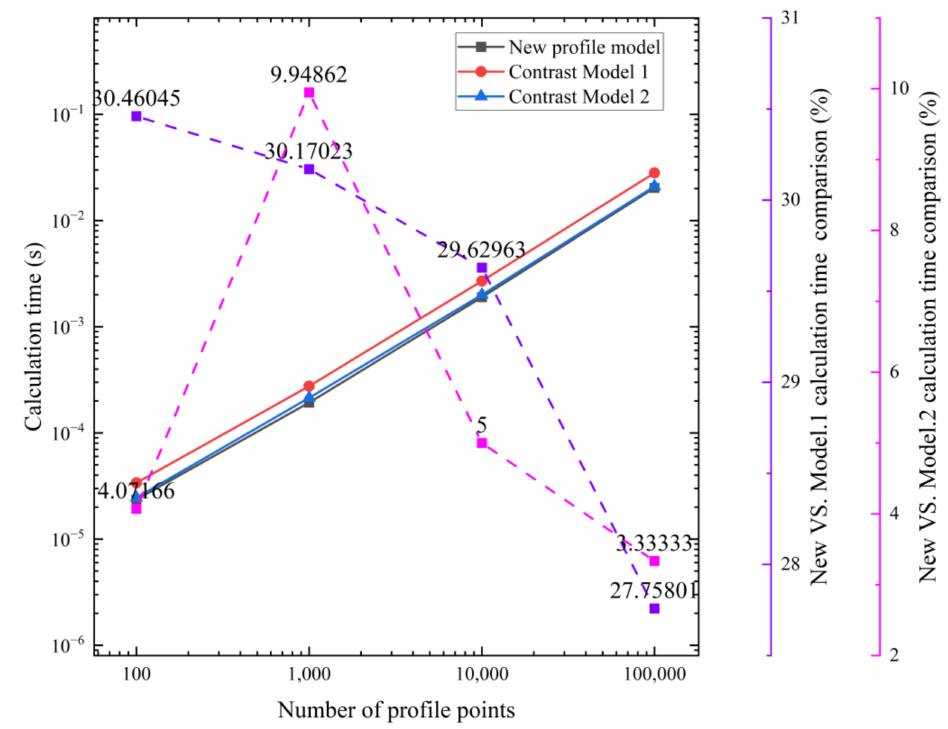
Figure 4. Computational efficiency